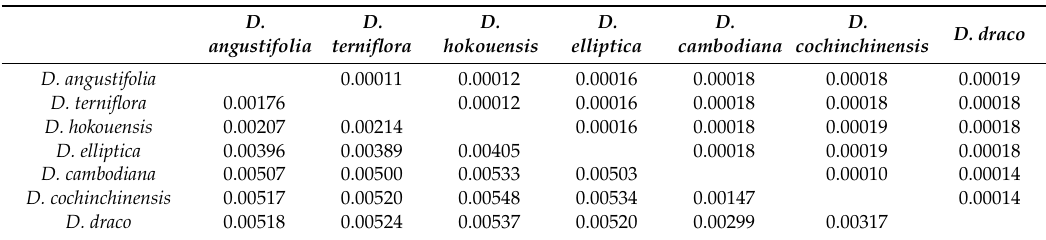
Table 5. Estimates of evolutionary divergence between Dracaena species. The number of base di ff erences per site from between sequences are shown. Standard error estimate(s) are shown above the diagonal and were obtained by a bootstrap procedure (1000 replicates). This analysis involved 7 nucleotide sequences. All positions containing gaps and missing data were eliminated (complete deletion option). There were a total of 154,129 positions in the final dataset. Evolutionary analyses were conducted in MEGA X